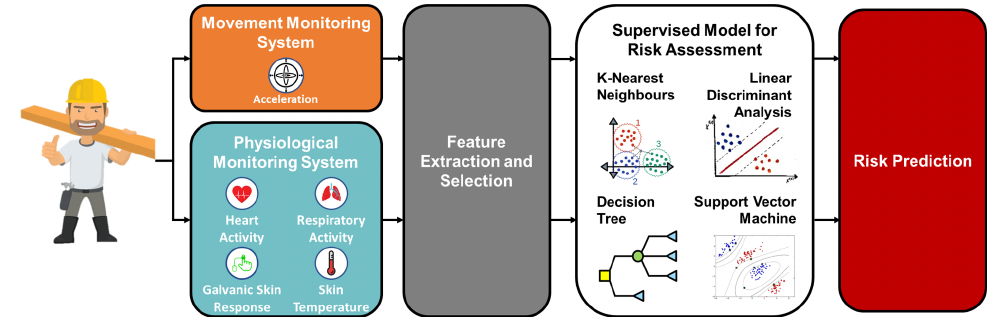
Figure 1. Block scheme of the proposed